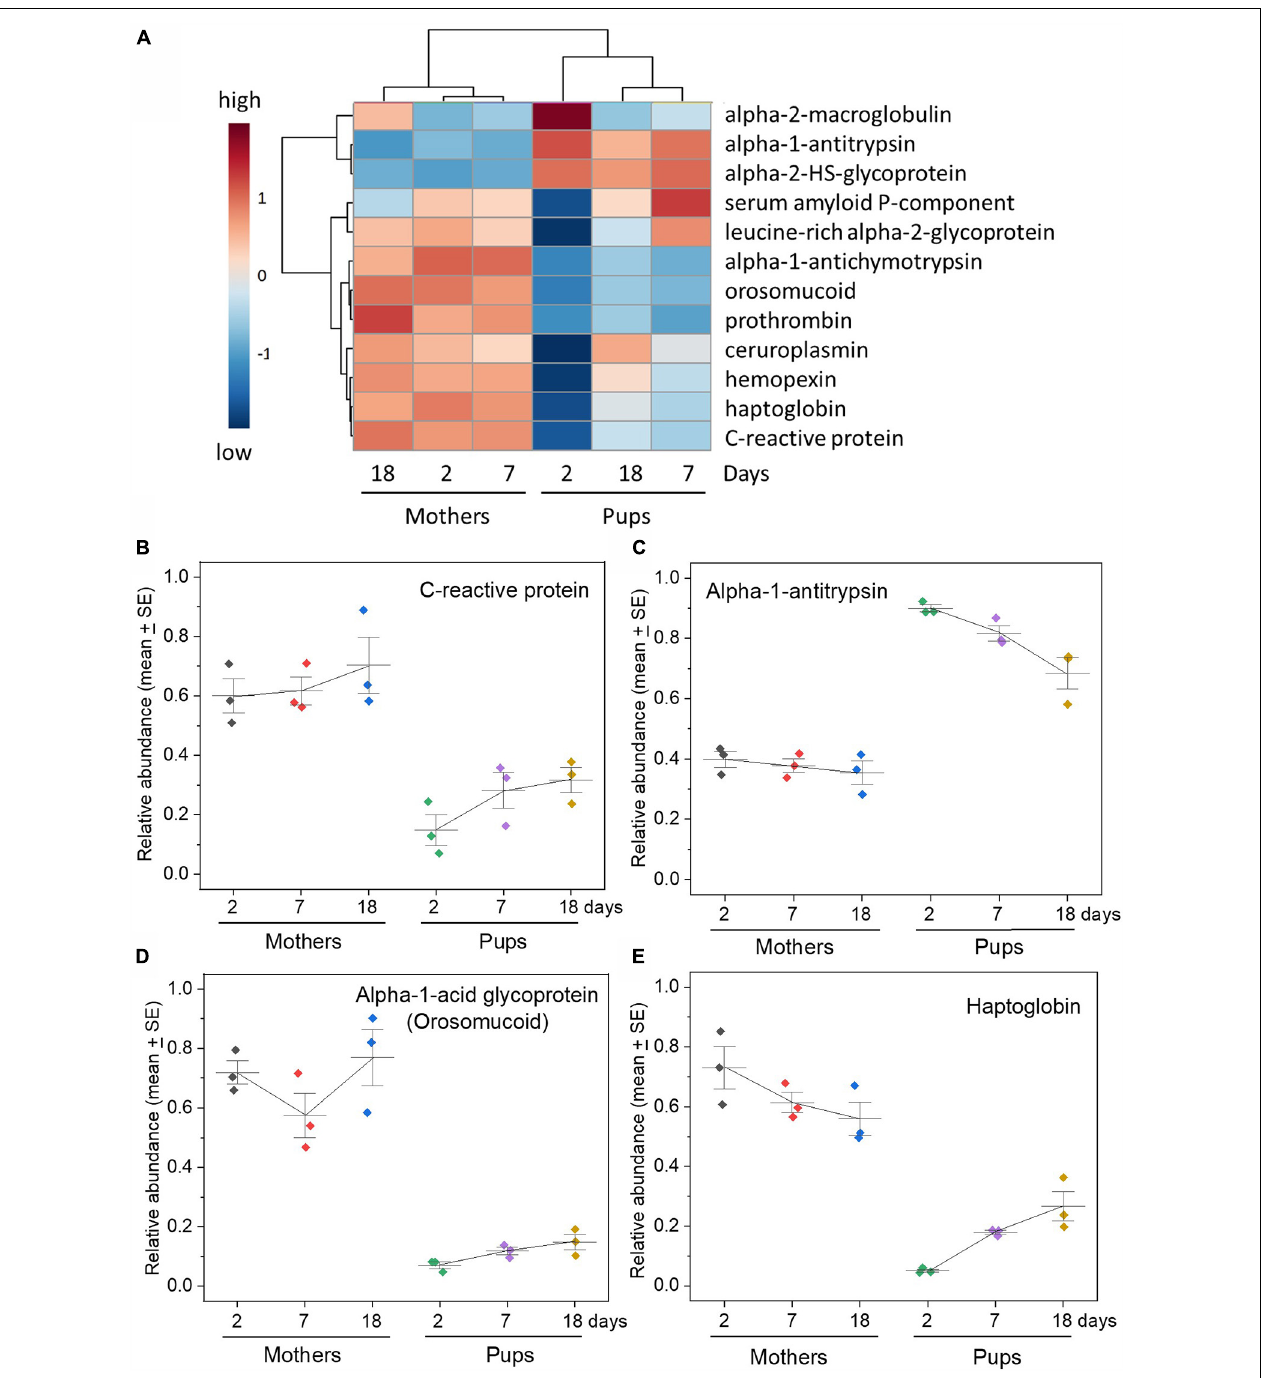
FIGURE 2 | Grey seal pups have low levels of acute phase proteins in their sera relative to their mothers. (A) Heatmap with hierarchical clustering of all the acute phase proteins included in the analysis with relative abundance values obtained from TMT proteomics from three mother and pup pairs sampled on days 2, 7, and 18 after birth. The TMT data were log transformed, and the heatmap was created with group averages (three pups on a given day after birth, three mothers on a given day). See Supplementary Figure 2 for a heatmap from the same data but for individual mothers and pups. The cluster dendrogram above the heatmap clearly differentiates mother sera from pup sera at all days, and the dendrogram to the left splits the acute phase proteins into two distinct groups. Note that the columns in each heatmap column do not follow day order because the analysis yields the overall relationship between days—as reflected in the hierarchical cluster. Despite this the mother and pup samples easily group and segregate. (B–E) Relative concentration changes in selected acute phase proteins (C-reactive protein, haptoglobin, alpha-1-acid glycoprotein (syn. orosomucoid), and alpha-1-antitrypsin) in mother and pup sera with time after birth. See Supplementary Figure 2 for graphs of all the acute phase proteins examined and mentioned in the main text. Relative abundance values are expressed in arbitrary units.